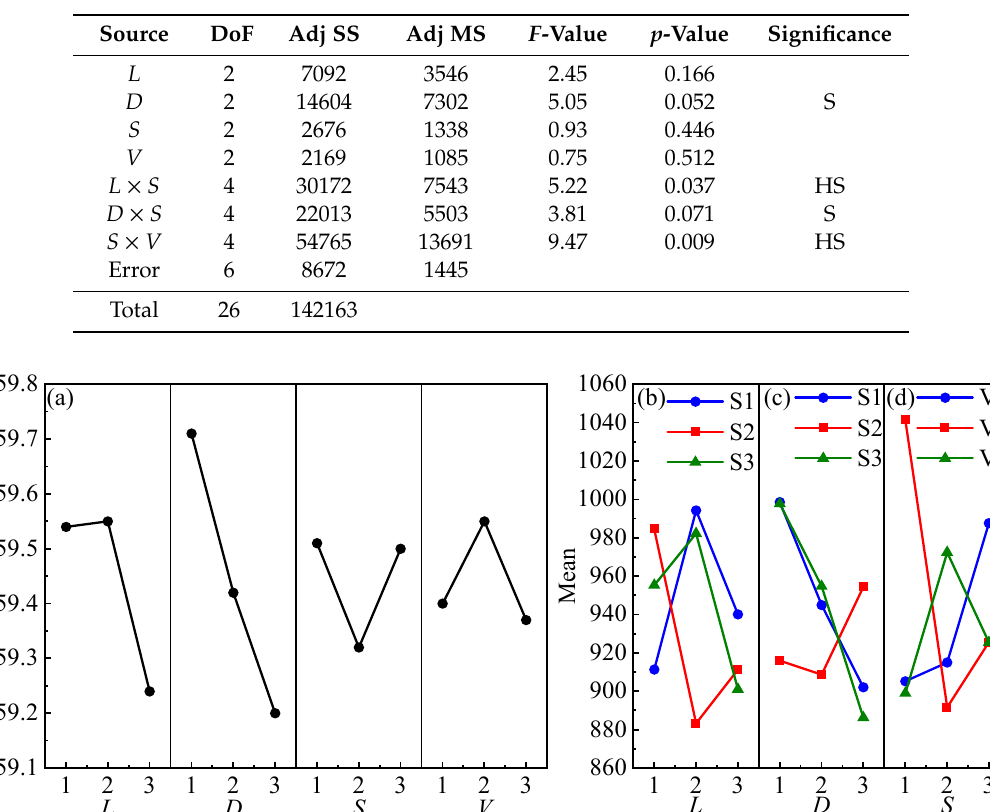
Figure 7. Effect of laser cladding parameters on micro-hardness of coatings: ( a ) the influence of single factors; ( b ) the interaction of S and L ; ( c ) the interaction of S and D ; ( d ) the interaction of V and S .